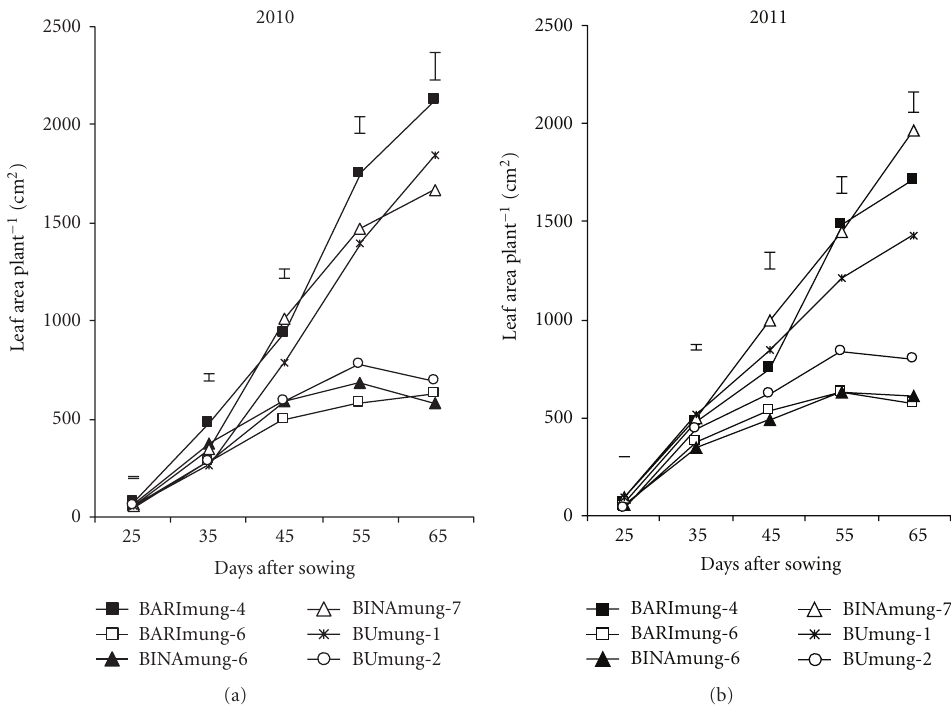
Figure 1: Leaf area development at di ff erent ages in six mungbean varieties. Vertical bars represent LSD (0.05).